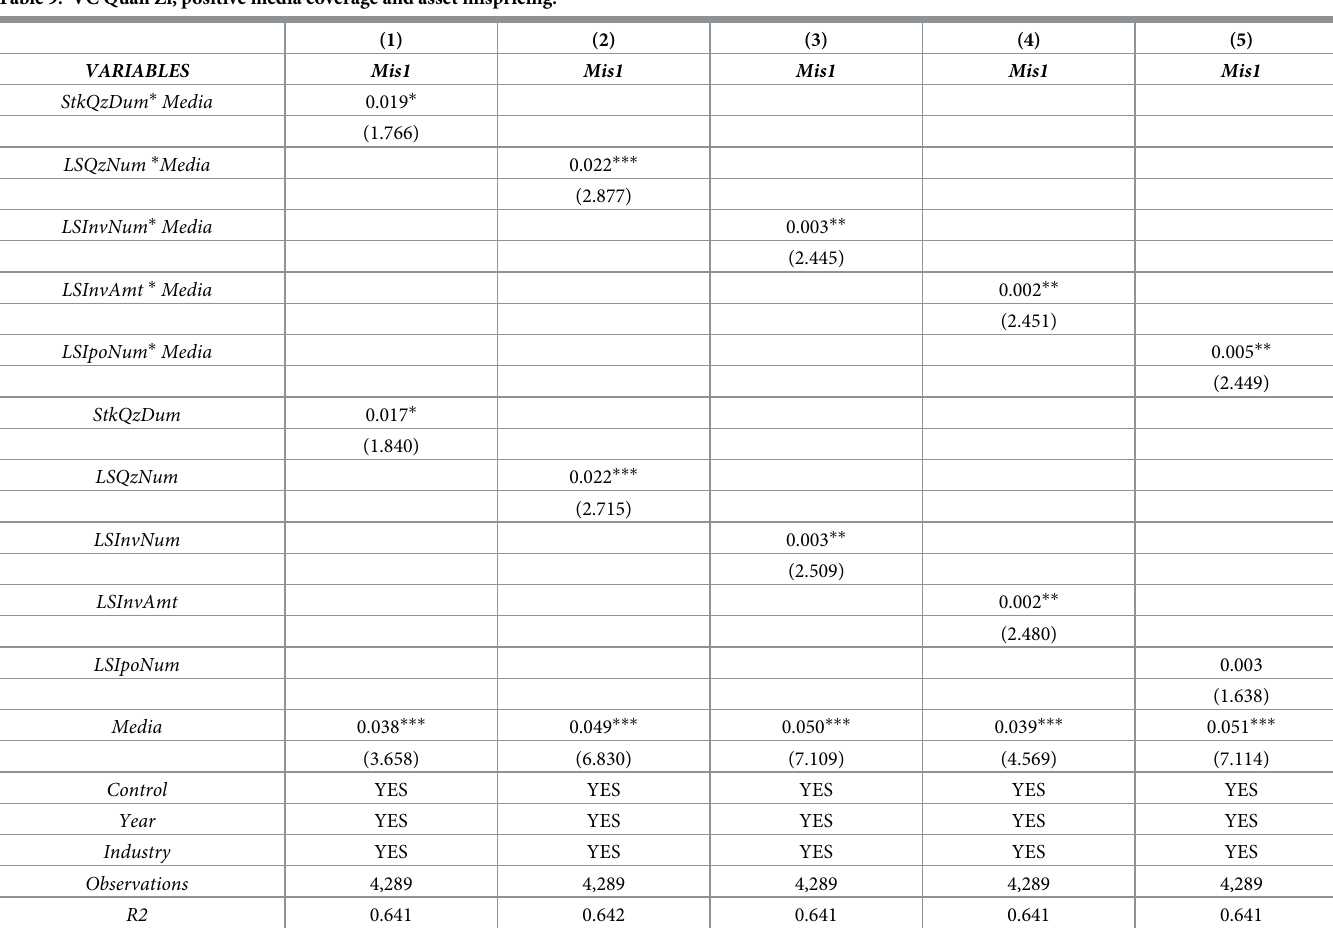
Table 9. VC Quan Zi, positive media coverage and asset